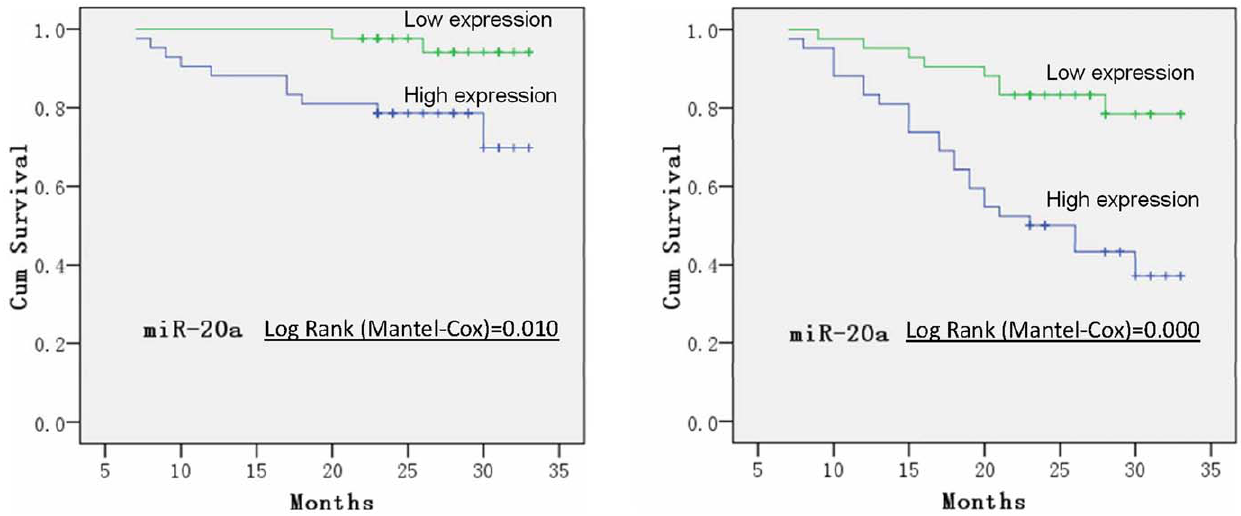
Figure 4. Kaplan-Meier survival curve analysis of miR-20a (Left: total survival curve; right: disease-free survival curve). Log Rank value=0.010 and 0.000, respectively, analyzed by Software